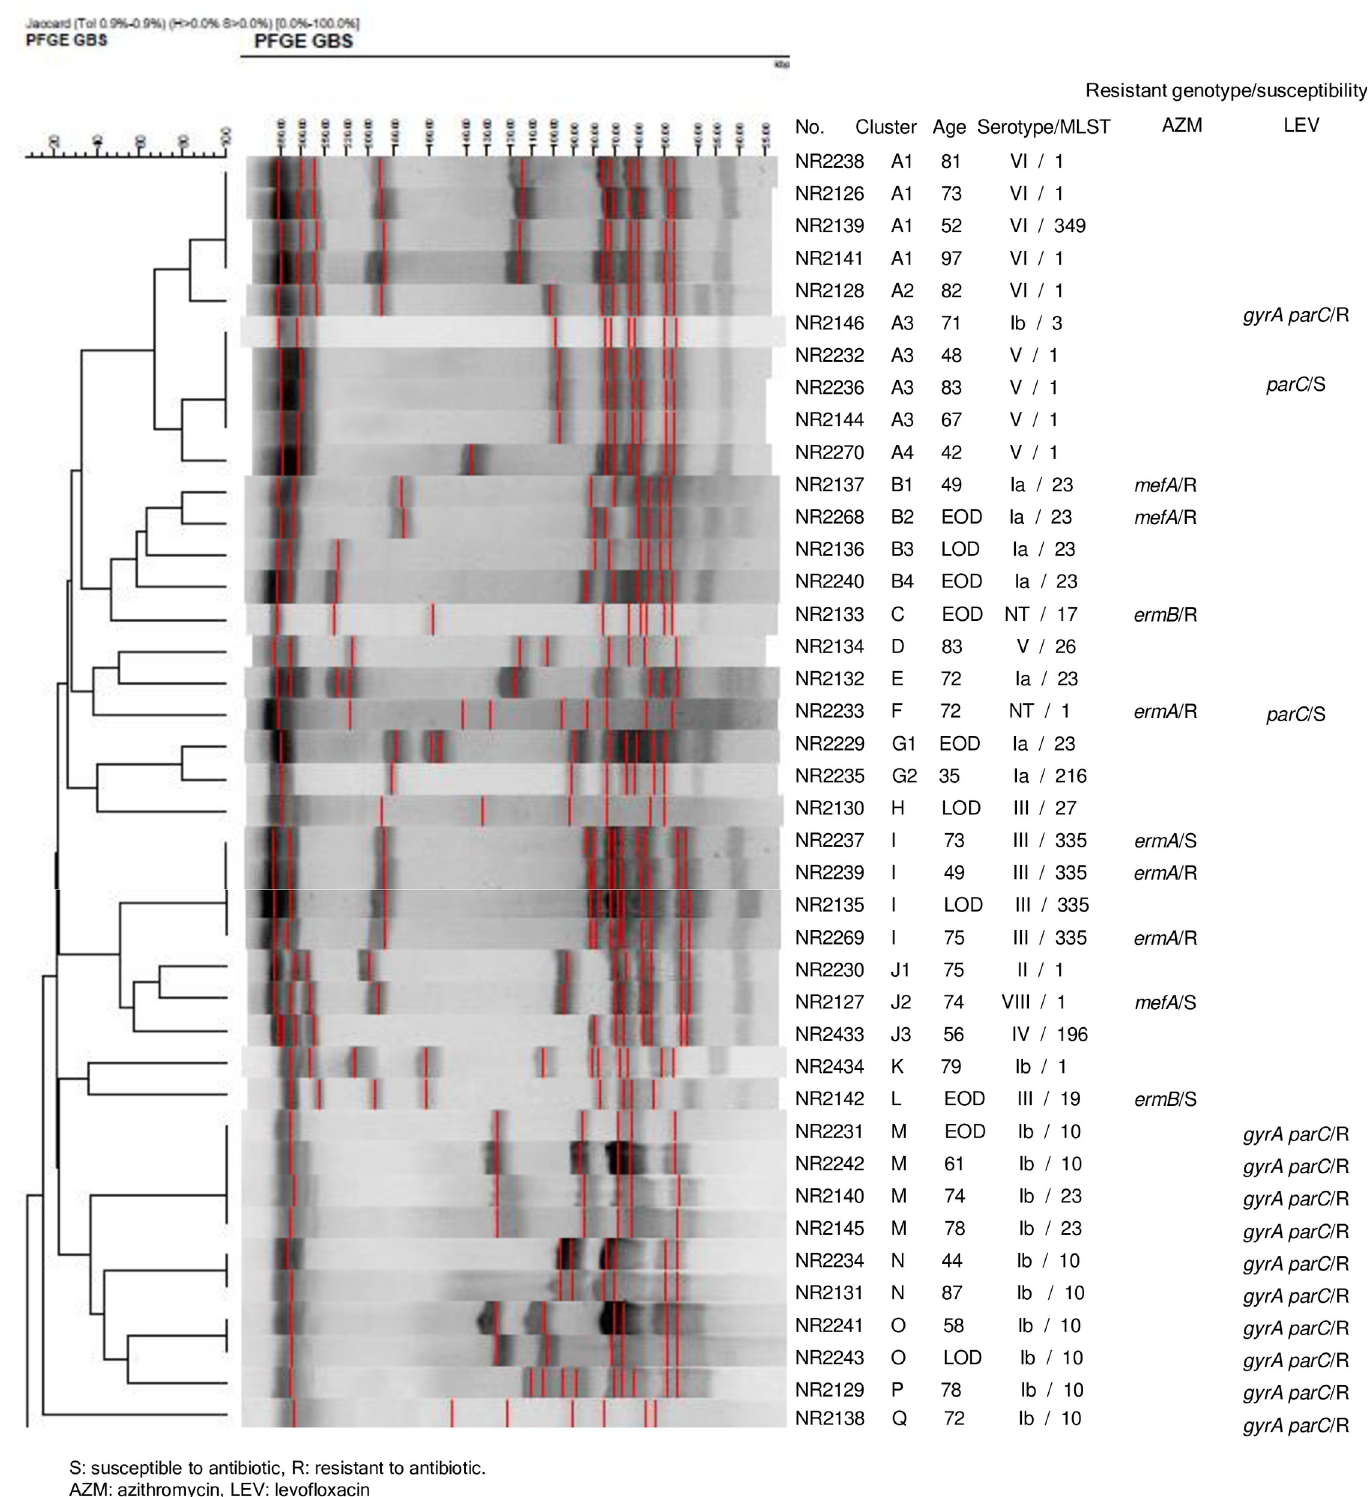
Fig 1. Analysis of PFGE patterns in the 40 GBS isolates.